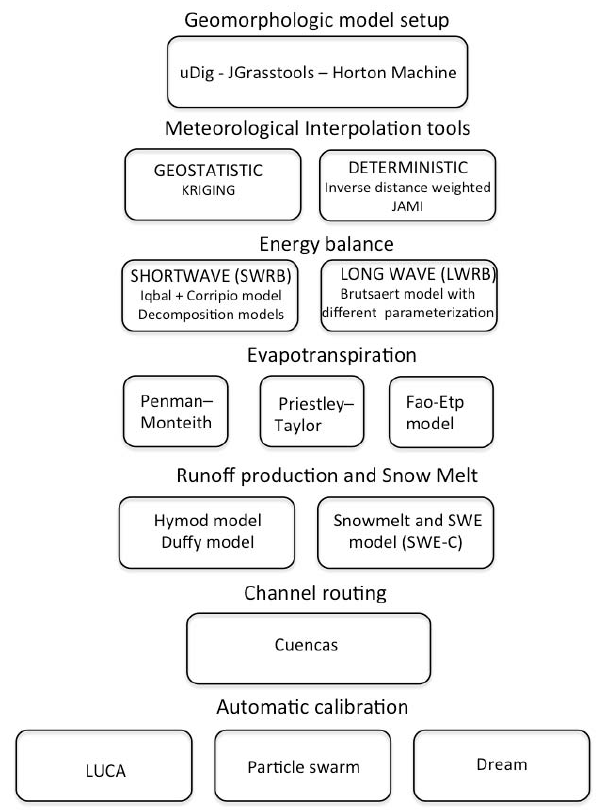
Fig. 1. The NewAge system showing all the modeling compo- nents, starting from the top: the uDig Geographic Information Sys- tem (GIS), the meteorological data interpolation tools, energy bal- ance, evapotranspiration, runoff production-routing and snow water equivalent. The user can select and connect different components and use automatic calibration algorithms (at the bottom) to optimize model